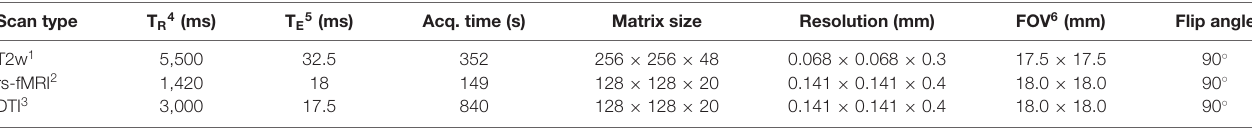
TABLE 1 | Characteristics of the performed 9.4 T MRT measurements.